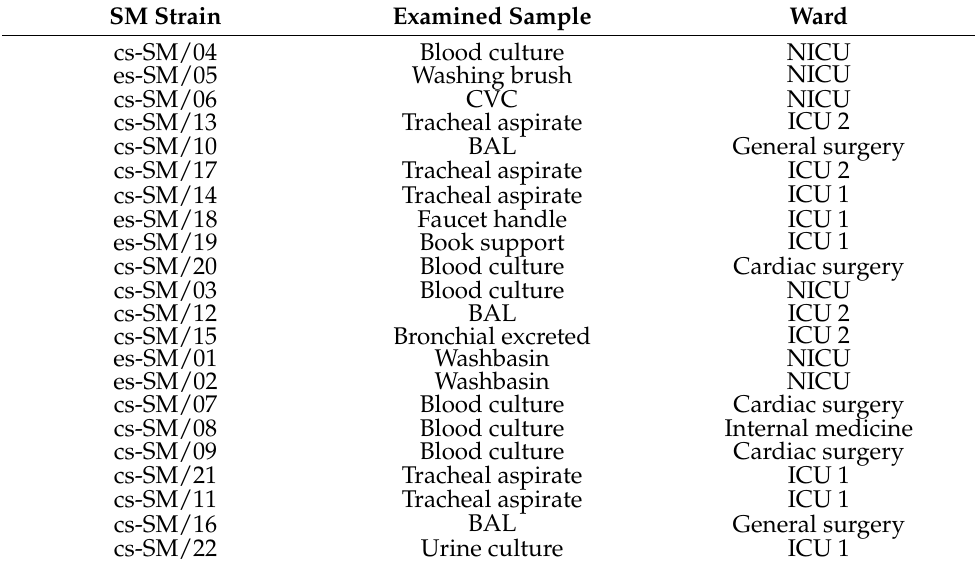
Table 1. Serratia marcescens isolated from clinical and environmental samples in different